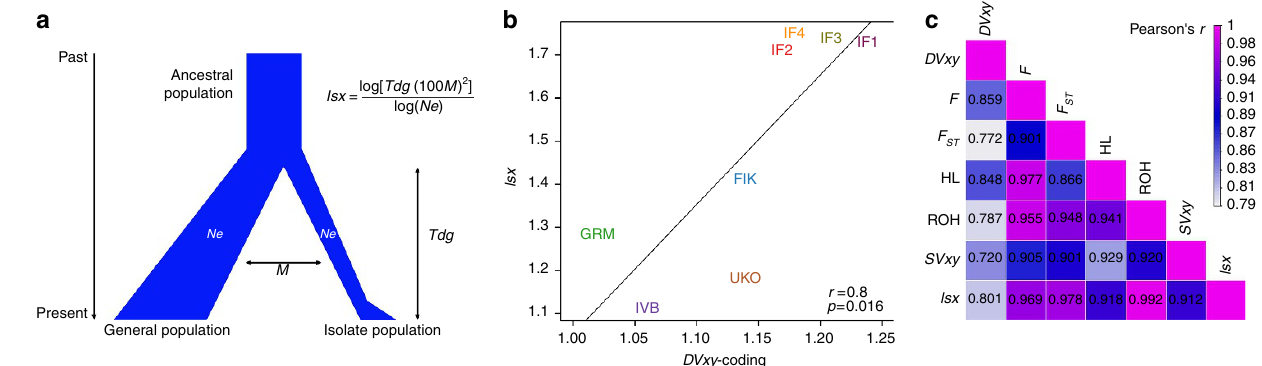
Figure 2 | Isolation index ( Isx ) and its correlation with other genetic measures. ( a ) Information summarized in Isx . ( b ) Example of the correlation between Isx and other statistics, here DVxy-coding . ( c ) Summary of the correlations between Isx and other population-genetic statistics. All the correlation coefficients are high and statistically